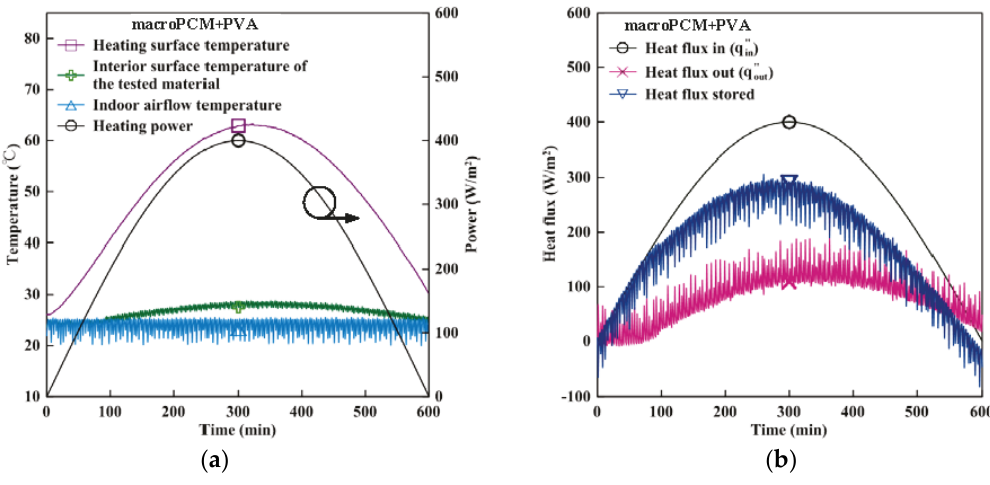
Figure 8. Heat transfer behavior of macroPCM + PVA ( G s,o = 400 W/m 2 ): ( a ) Temperature changes with time; ( b ) Heat flux changes with time.